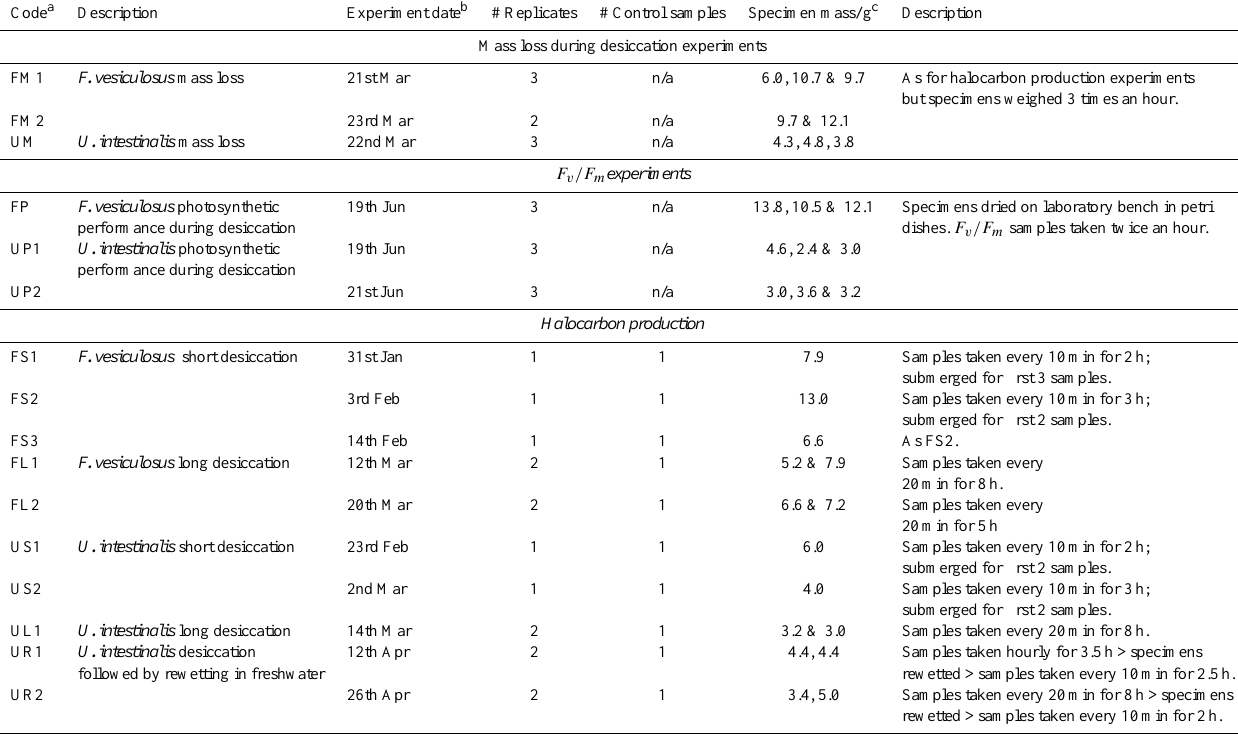
Table 1. A summary of the desiccation experiments conducted as part of this study.